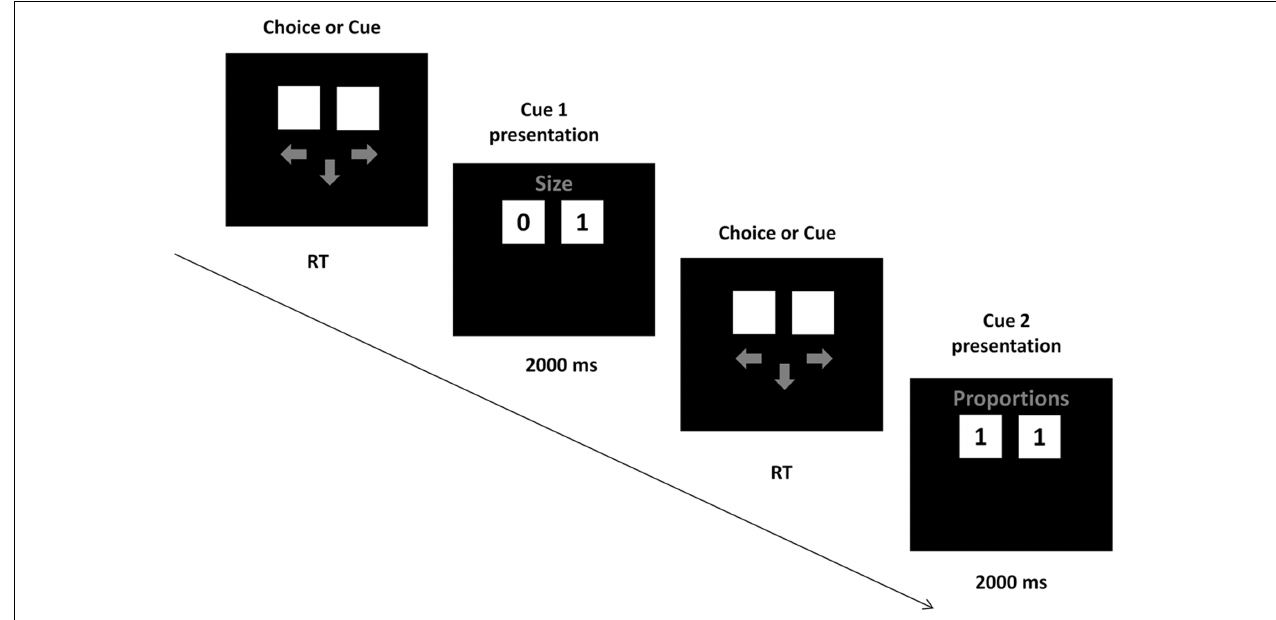
FIGURE 1 | Task presentation. In each trial, participants could either request a cue or make a choice, by pressing the down arrow button (next cue) or left or right arrow buttons (choice). On a given trial, a cue either discriminated between the alternatives (one alternative had a “0” value and the other had a “1” value) or did not discriminate (both alternatives had the same cue